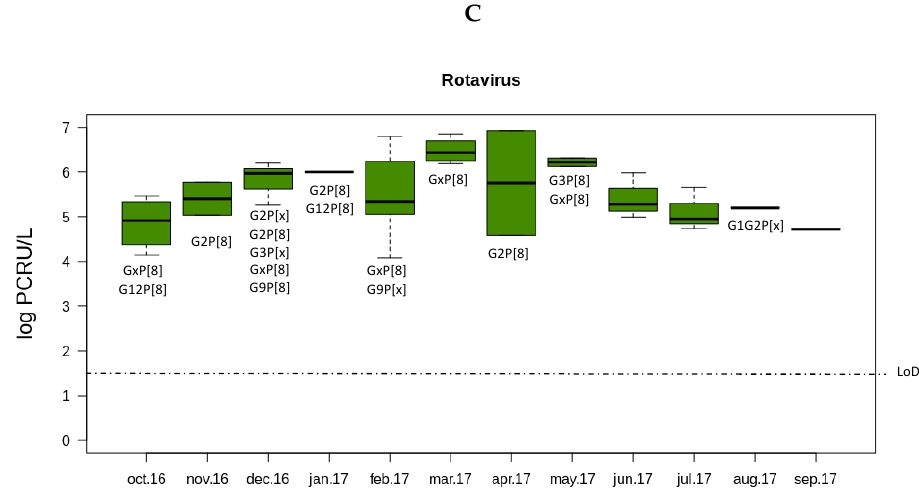
Figure 1. Overview of the concentrations and genotypes of enteric viruses detected in sewage. Boxplots show median concentrations (log PCRU / L) with the 25th and 75th percentile values of norovirus GI ( A panel in dark blue), norovirus GII ( B panel in light blue), and rotavirus ( C panel in green). Viral genotypes are indicated according to the month in which the sample was sampled.